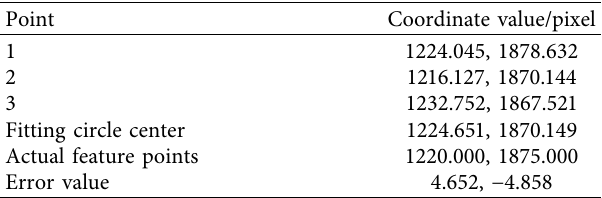
Table 2: Contour intersection and fitting center error.